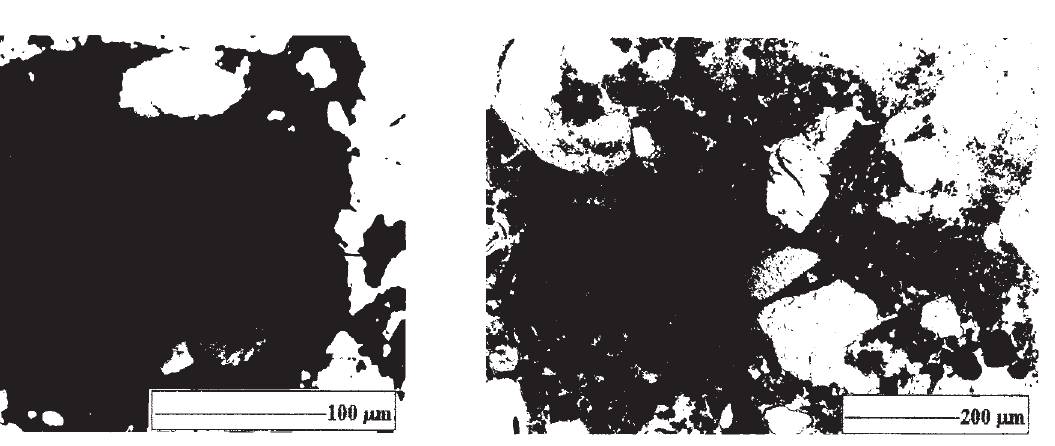
Figura 9. Macroagregados orgânicos do horizonte A do perfil sob mata nativa inteiramente rodeados por poros largos